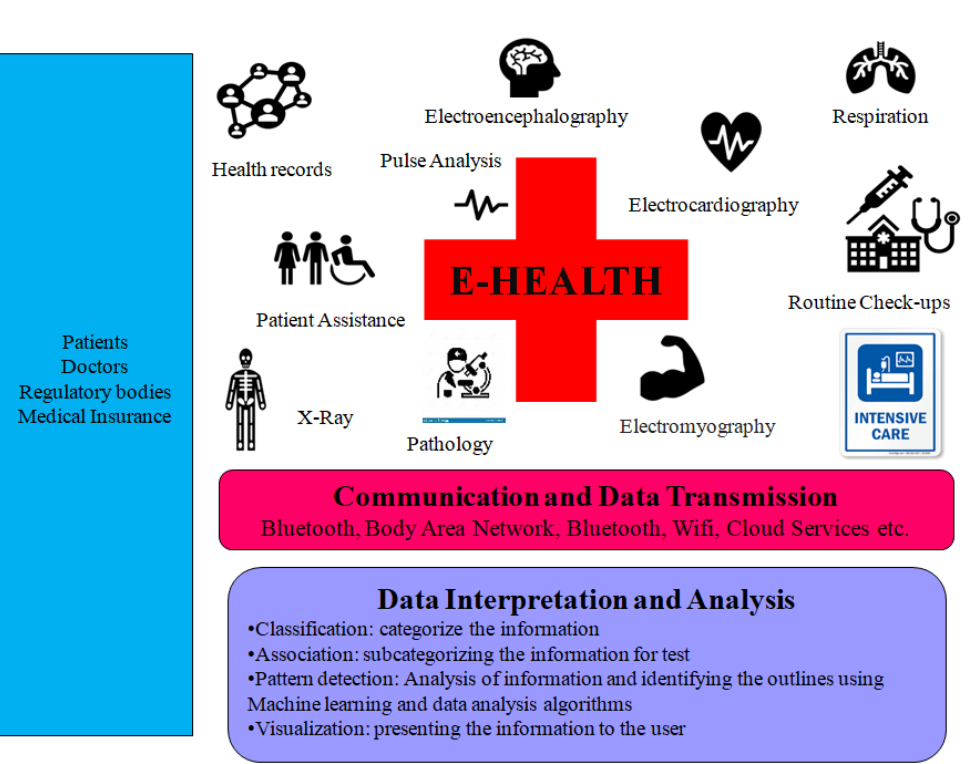
Figure 6. Intelligent Sensing in Healthcare